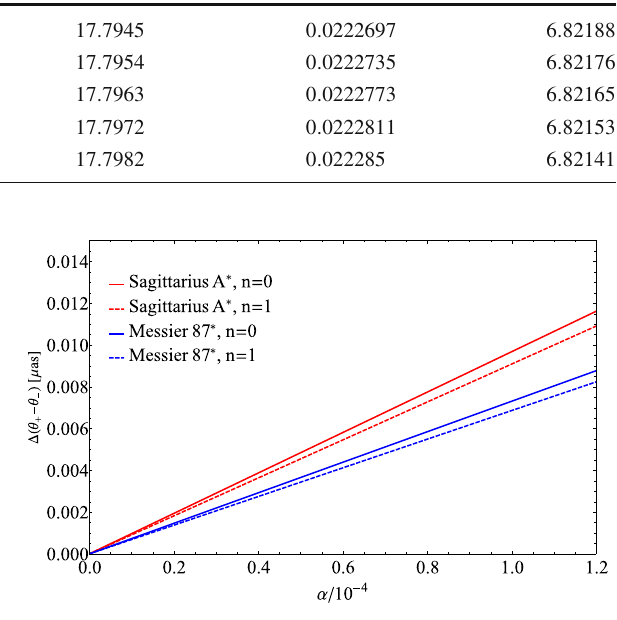
Fig. 7 Therelativedifference (cid:25)(θ + − θ − ) asafunctionof α forSMBHs of Sagittarius A ∗ and Messier 87 ∗ as retrolens and the winding number n = 0 , 1